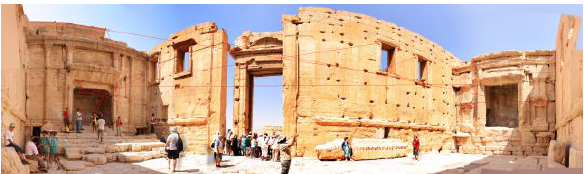
Figure 9: The central panorama of the interior with collimations of the orientation network points in "Point Records" software for the panoramic spherical photogrammetry.